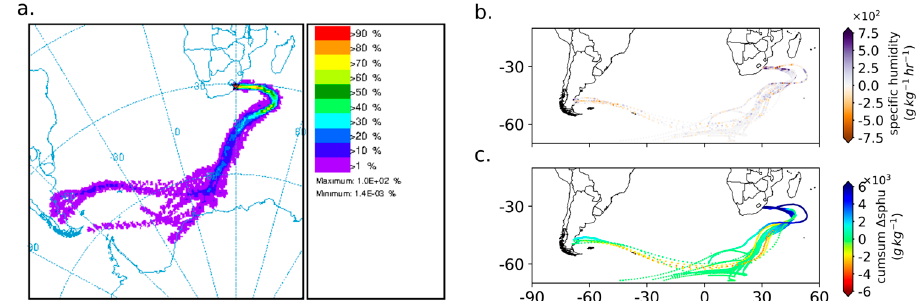
Figure 11. ( a ) The accumulative frequency of backwards trajectories from the Margate station using the HYSPLIT model starting at 11 April 2022 and going back 8 days. And ( b ) the loss/gain of specific humidity (shaded; g kg − 1 hr − 1 ) along the different pathways (top). Brown colours indicate a loss of specific humidity, while purple implies a gain. The bottom panel, ( c ), shows the cumulative sum of specific humidity along the different trajectories.